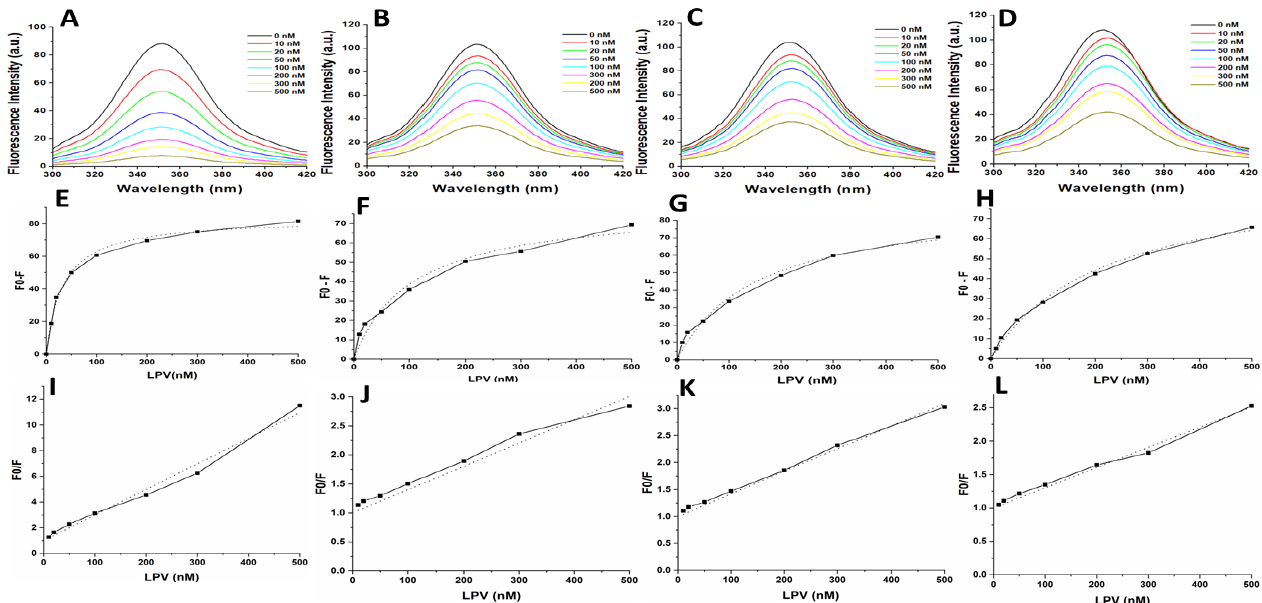
Figure 5. ( A – D ) Intrinsic tryptophan fluorescence quenching using LPV for the WT, MUT-1, MUT-2, and MUT-3 respectively. ( E – H ) Change in intrinsic tryptophan fluorescence for determination of K i using LPV for the WT, MUT-1, MUT-2, and MUT-3 respectively. ( I – L ) Stern–Volmer plot to determine the quenching constants ( K sv ) using LPV for the WT, MUT-1, MUT-2, and MUT-3 respectively.